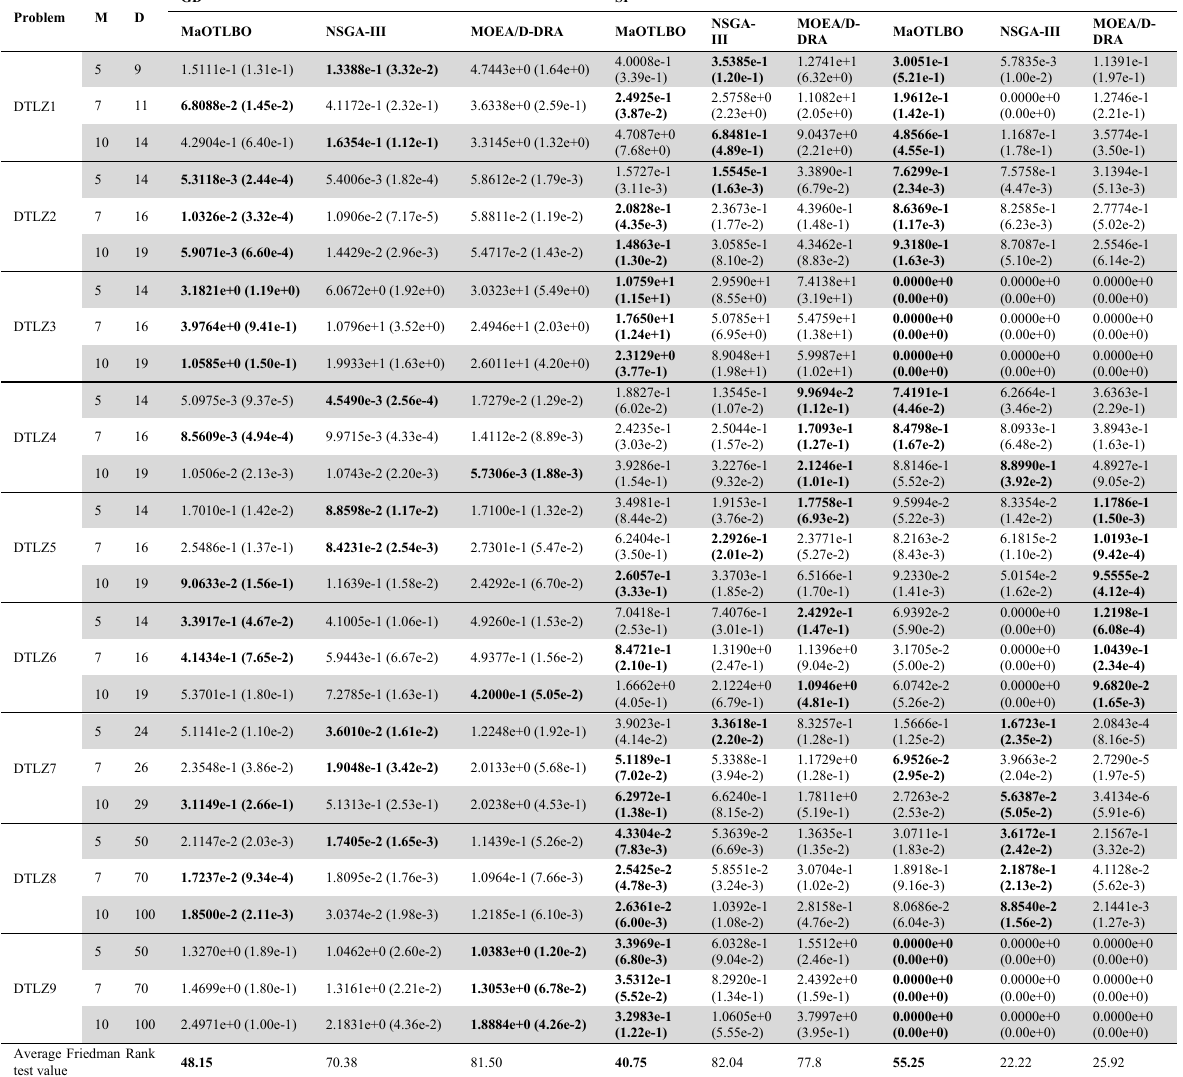
Fig. 7. Obtained Pareto front on DTLZ1-DTLZ9 10-objective problems using MaOTLBO algorithm As seen in Fig. 7, the Pareto front is obtained by the MaOTLBO algorithm for 10 objective cases. As seen in Fig. 7, the proposed MaOTLBO converges to a large number of optimal solutions with good diversity maintenance for all selected DTLZ test functions. Table 1 GD, SP, and HV indicators comparison based on DTLZ1-DTLZ9 5, 7, 10-objectives test